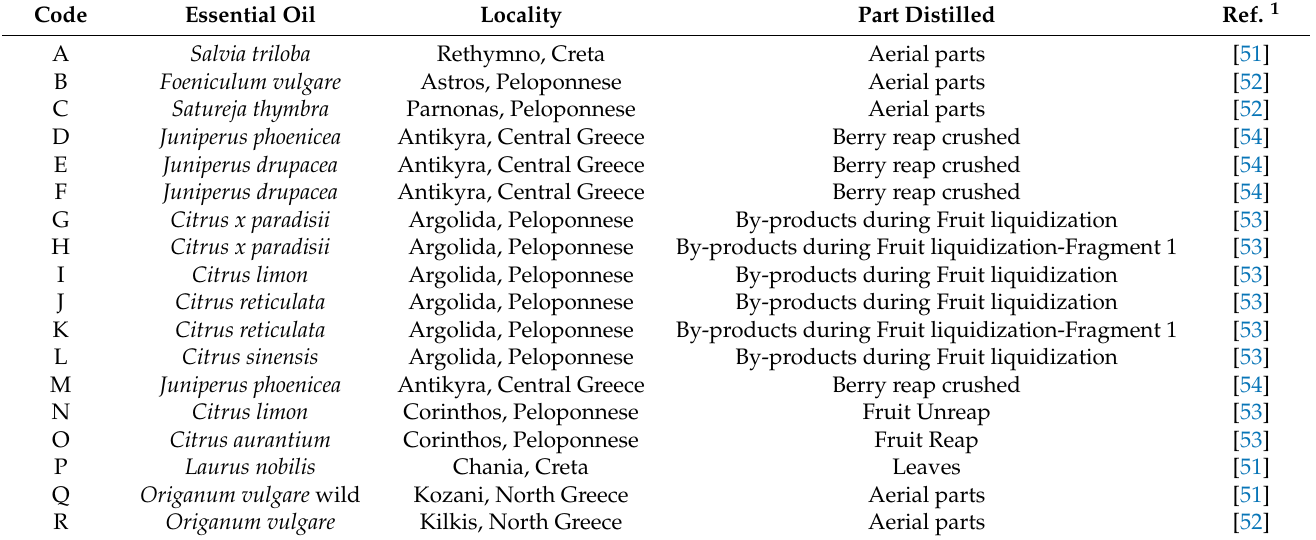
Table 1. Collection data of tested essential